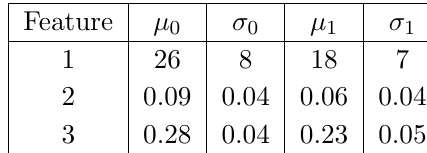
Figure 1 . Receiver Operator Characteristic (ROC) curves for instance classi(cid:12)cation, using three individual features and then combined using a fully supervised network and the weakly supervised classi(cid:12)er. One performance metric is the Area Under the Curve (AUC) which is the integral of the ROC curve.